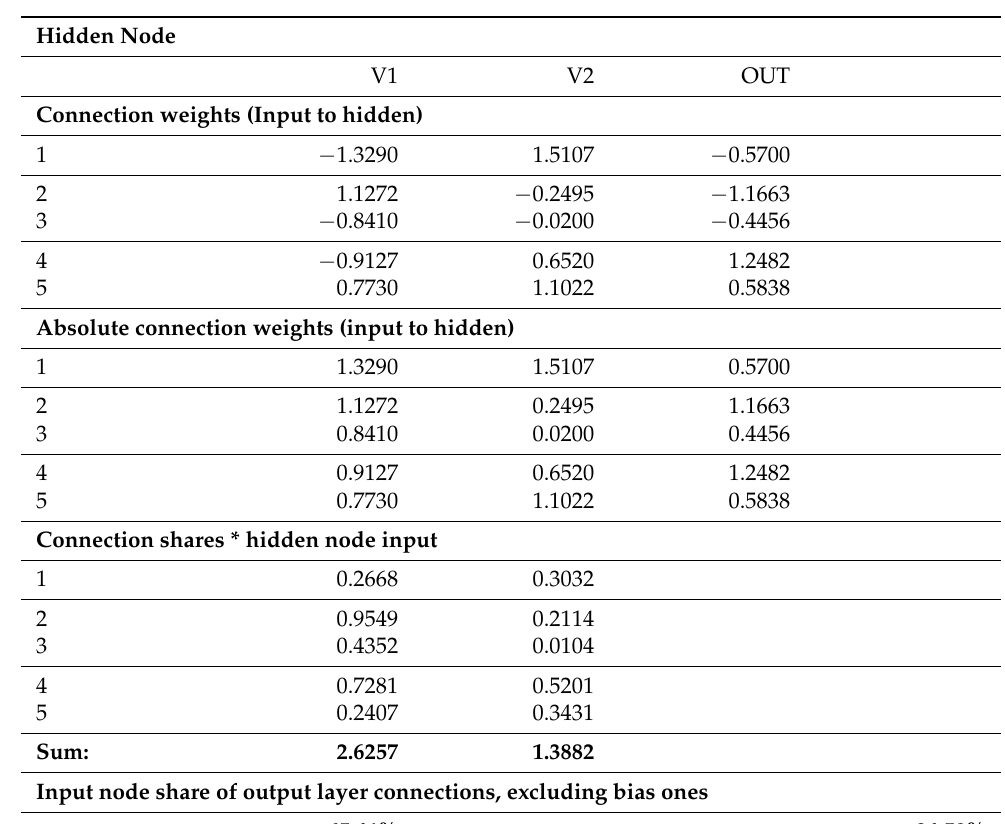
Table 6. The interpreting neural − network connection